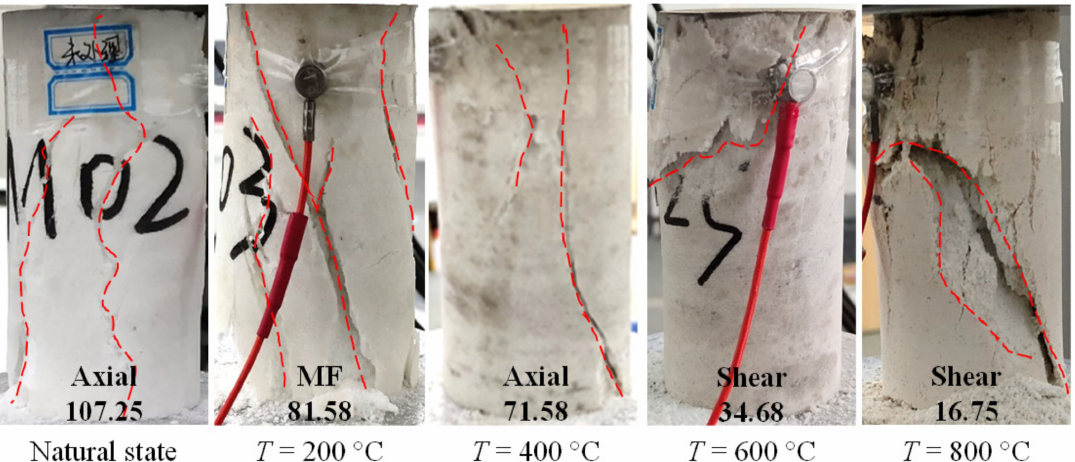
Figure 9. Ultimate failure modes for marble specimens at different temperature levels. Failure modes and corresponding compressive strength (in MPa) are marked. (Axial denotes axial splitting, MF denotes multiple fracturing, Shear denotes shearing